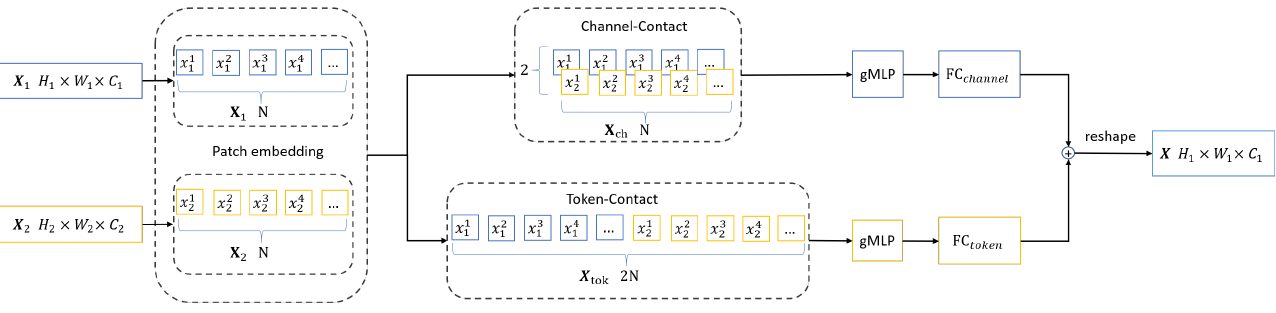
Figure 5. The Cross MLP